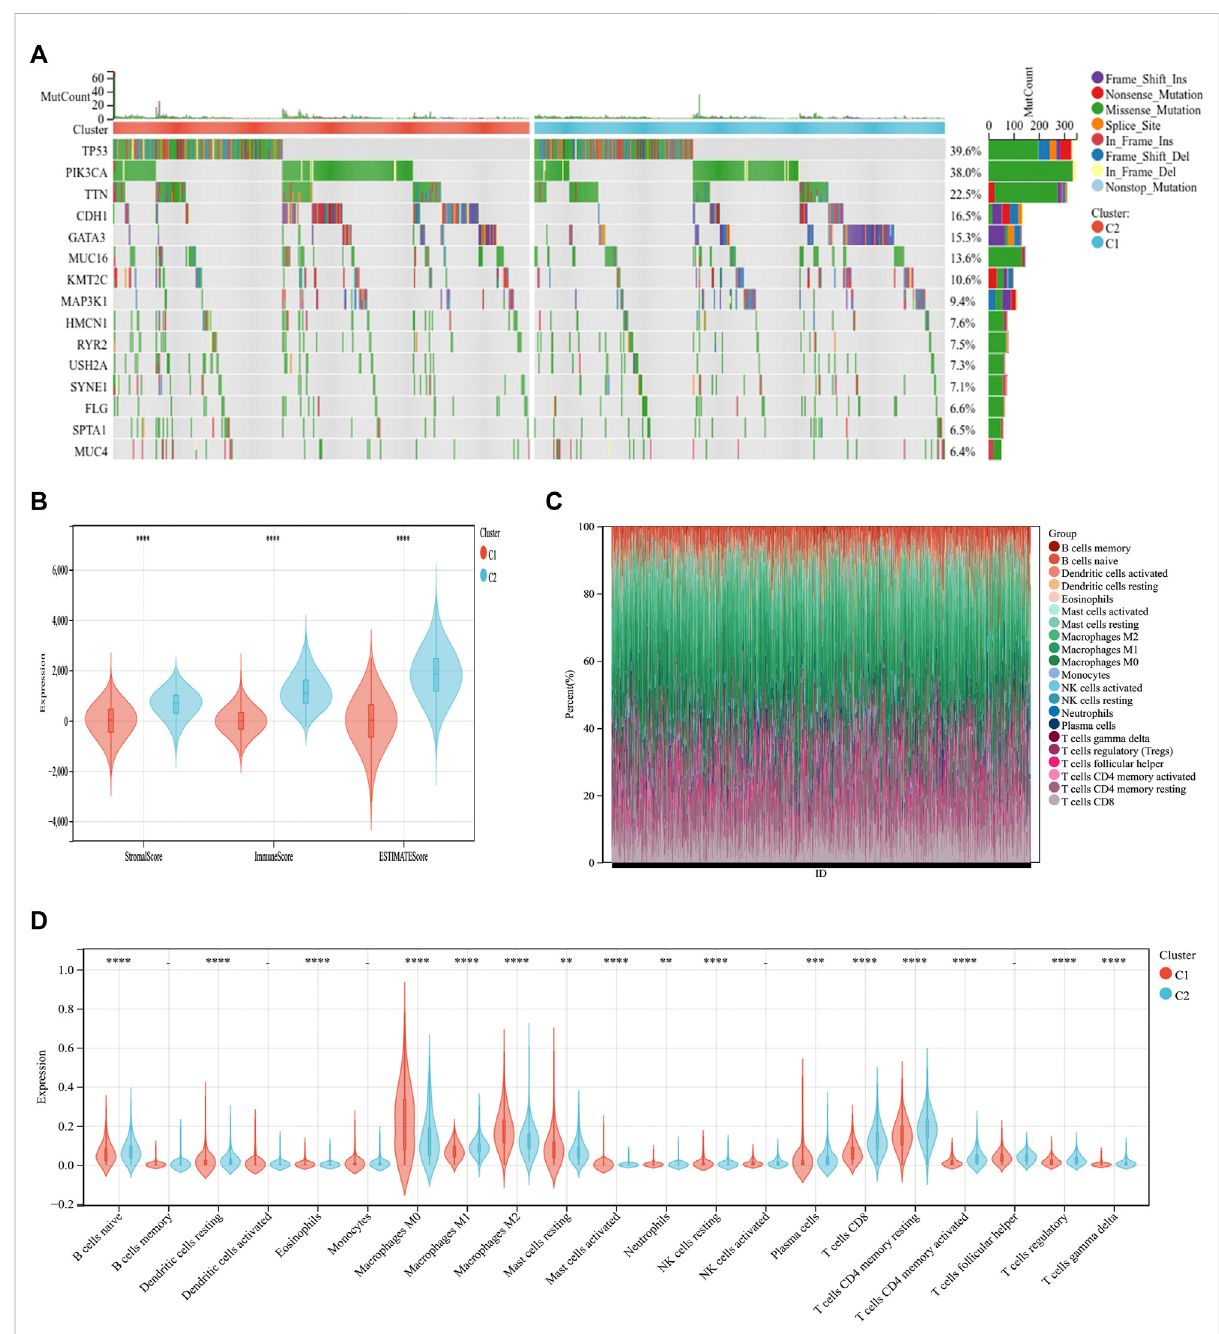
FIGURE 3 Differential somatic mutations and immune in fi ltration in two ICD subtypes. (A) Gene mutation map showing that the 10 most commonly mutated genesinBCdifferinmutationsbetweentheC1andC2groups. (B) ESTIMATE violinplotshowingthedifferencesinthestromalandimmune cells in fi ltrating C1 and C2. (C) The relative proportions of immune-in fi ltrating types in C1 and C2. (D) CIBERSORT violin plot showing multiple differences in immune cell enrichment between the two ICD subtypes. * p < 0.05, ** p < 0.01, *** p < 0.001, **** p <